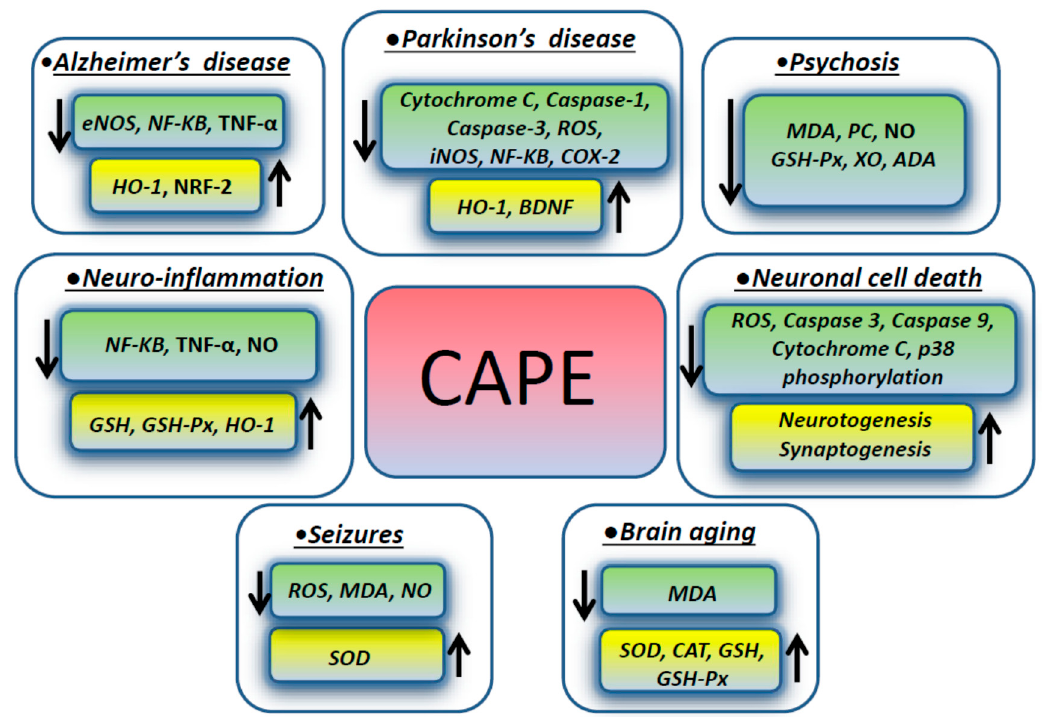
Figure 1. CAPE effects on intracellular molecules and pathways in different neurologic disorders.